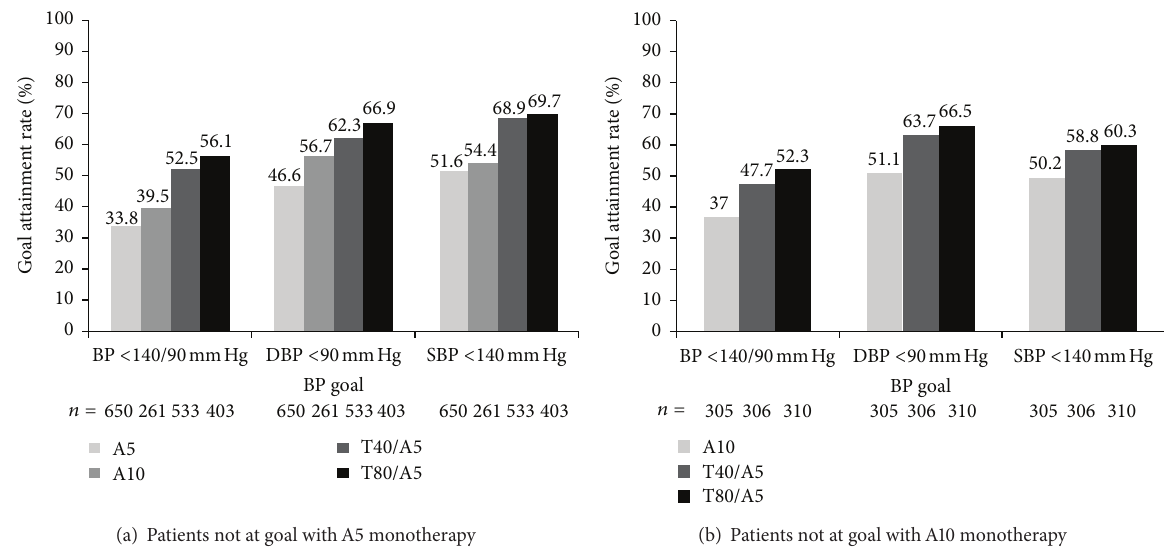
Figure 3: BP goal attainment rates at week 8. A5: amlodipine 5mg; A10: amlodipine 10mg; BP: blood pressure; DBP: diastolic blood pressure;